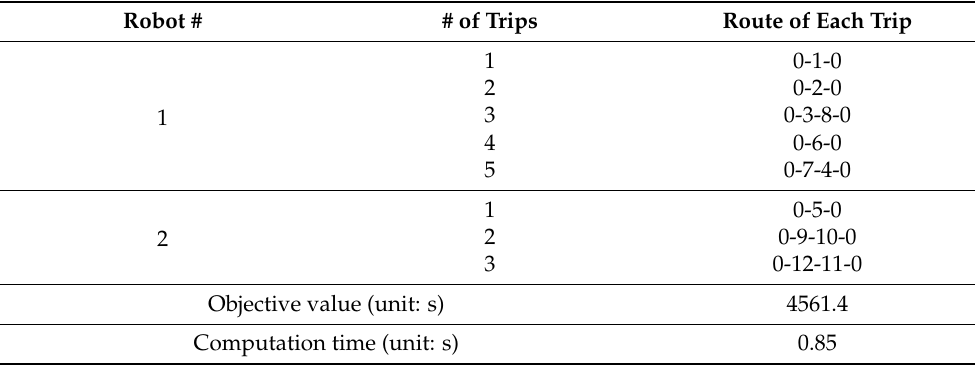
Table 6. Experimental results for the illustrative example with IRRP. Robot # # of